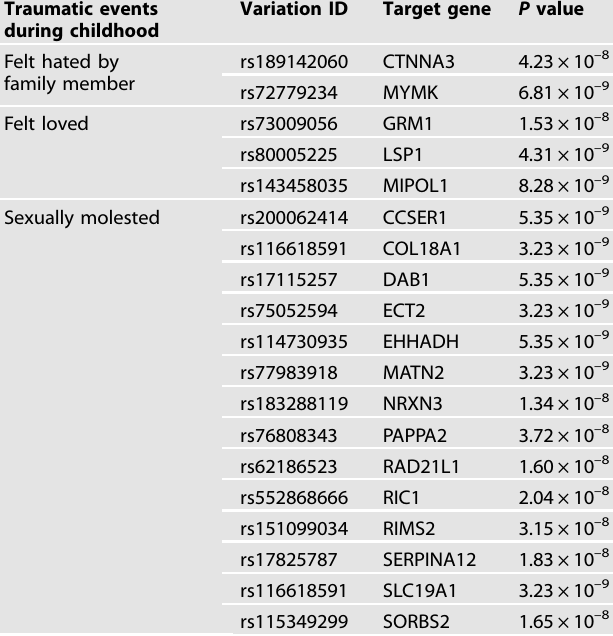
Table 2. The summary of genetic variants interacting with traumatic events during childhood in the frequency of cigarette smoking.